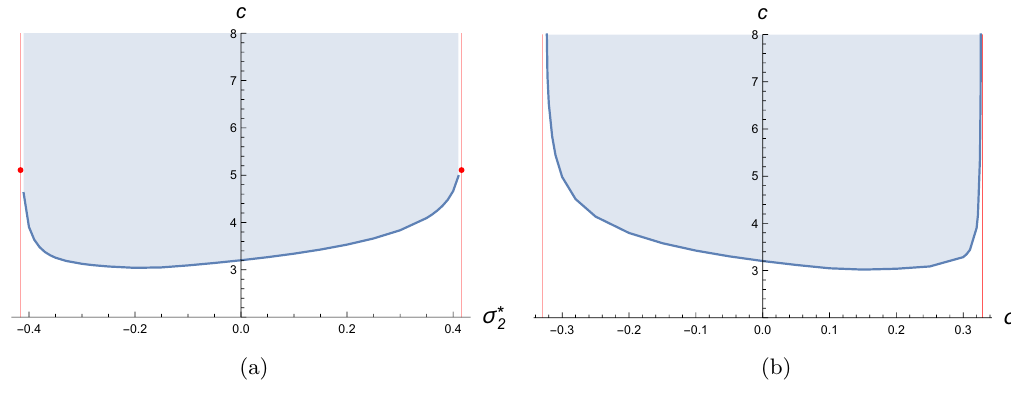
Figure 11 . Bounds on the central charge in O( N ) models. The allowed region is depicted in blue. Both plots are constructed with N = 7 and N max = 30. Left : the bound on the central charge as a function of (cid:27) (cid:3) on the section (5.31). The vertical lines correspond to (cid:27) (cid:3) 0 : 415927. The red 2 2 (cid:25) (cid:6) dots represent the two particle contribution to the central charge c 2 5 : 11 in the NLSM estimated (cid:25) in section 4.3. Right : the bound on the central charge as a function of (cid:27) (cid:3) on the section (5.32). 1 The vertical lines correspond to (cid:27) (cid:3) 0 : 1 (cid:25) (cid:6)